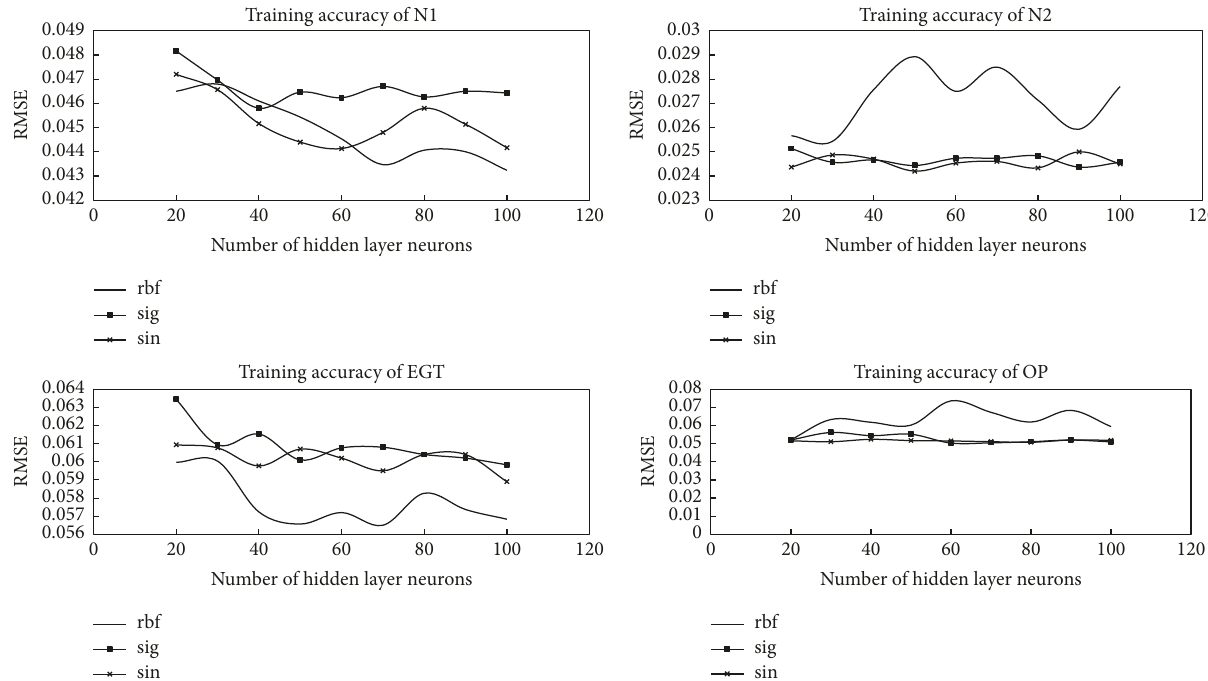
Figure 2: Training accuracy with different activation